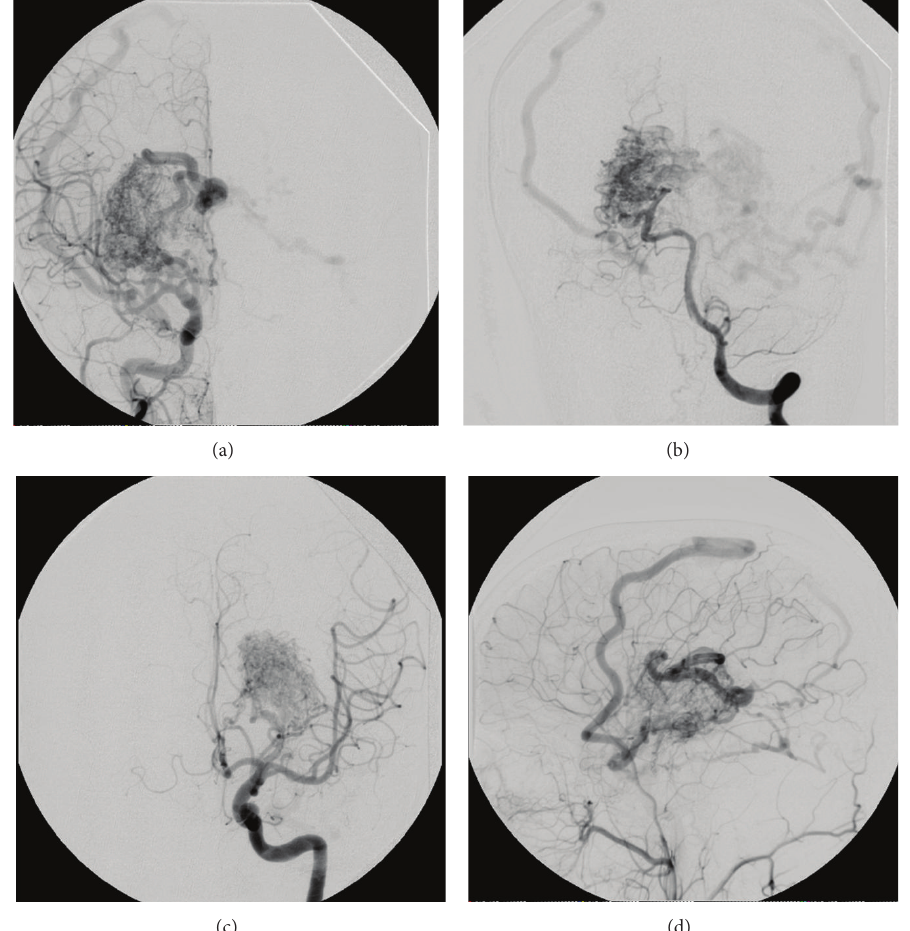
Figure 2: Diagnostic cerebral angiogram at initial presentation. (a) AP right carotid injection. (b) AP left vertebral injection. (c) AP left carotid injection. (d) Lateral right carotid